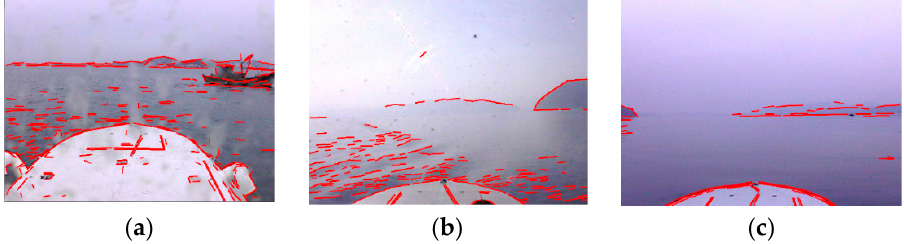
Figure 7. Line feature detection results of optical images in typical adverse weather conditions. ( a – c ) are optical images with extracted line features.